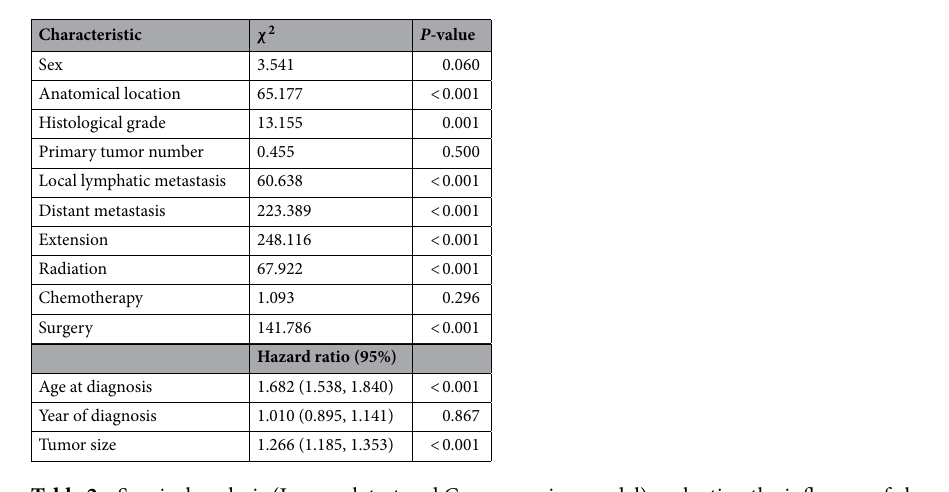
Table 2. Survival analysis (Log-rank test and Cox regression model) evaluating the influence of characteristics for osteosarcoma patient